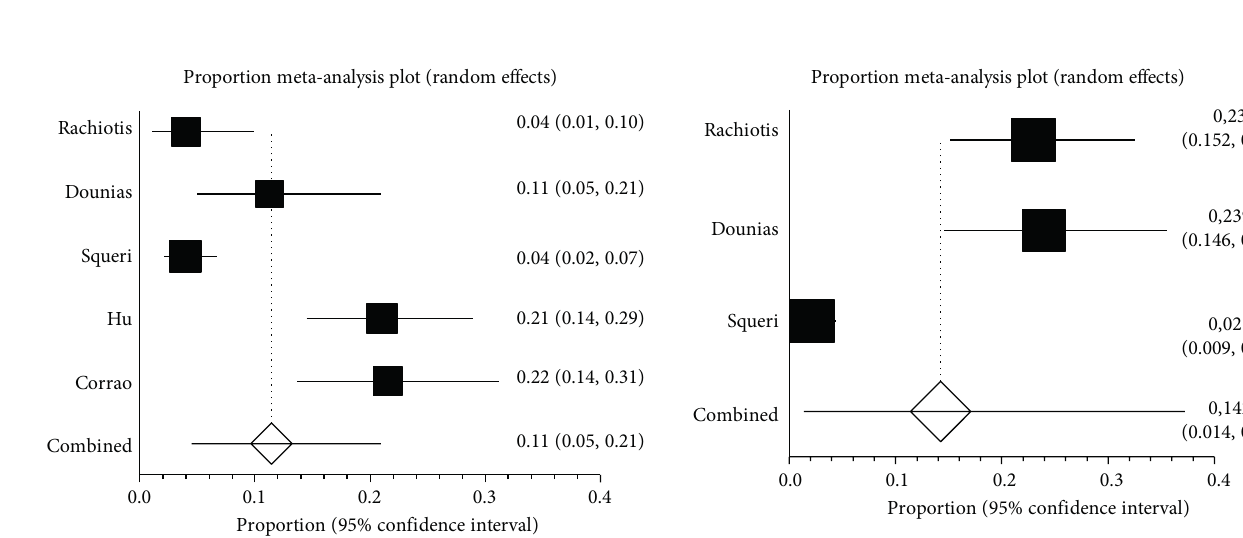
Figure 3: Proportion meta-analysis plot of HBs-Ab among